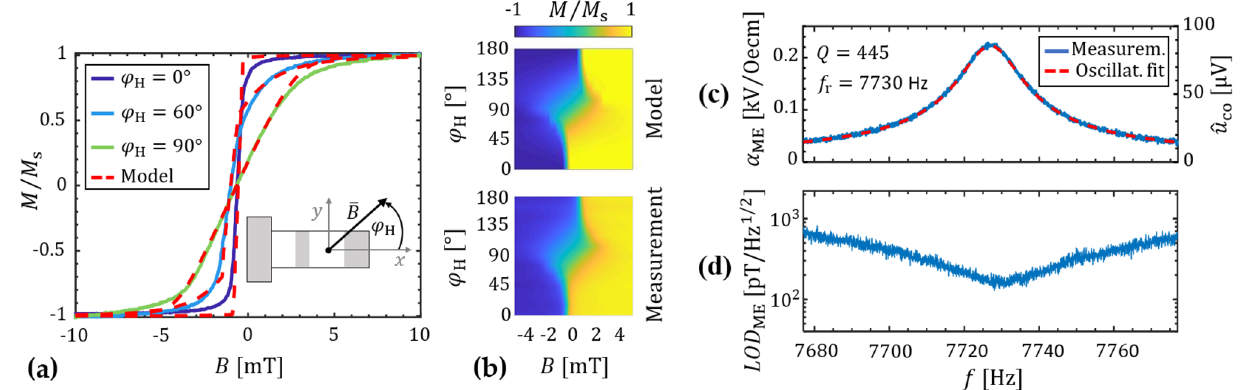
Figure 2. Magnetic and magnetoelectric properties. ( a ) Magnetization loops measured with a BH-loop 0 ◦ ) , the tracer in three different directions are compared with the simulations: along the long axis (ϕ H = 90 ◦ ) , and an example orientation in between (ϕ H 60 ◦ ) . For the exchange bias field a short axis (ϕ H = = 0.8 mT and orientation of (ϕ ex 46 ◦ ) is obtained. ( b ) Comparison of measured and modeled magnitude B ex ≈ = 0 ◦ 180 ◦ . ( c ) Magnetoelectric coefficient α ME of the first bending magnetization curves in the range of ϕ H = − mode (RM1), calculated via Eq. (1) from the measurements. The ac magnetic flux density is applied along the 100 nT . From a harmonic oscillator fit a quality factor of Q 1 445 and x-axis ( a ) with an amplitude of ˆ B ac = ≈ 7728 Hz are calculated. ( d ) Detection limit measured around the first a resonance frequency of about f r,1 = 150 pT/ √ Hz is obtained at f r,1 with encapsulation, and bending mode. A minimum value of about LOD ME = an estimated value of approximately LOD ME = 30 pT/Hz orientation and magnitude found experimentally from the x-axis offset of the two measured hysteresis curves 0 ◦ and ϕ H 90 ◦ . along ϕ H = =